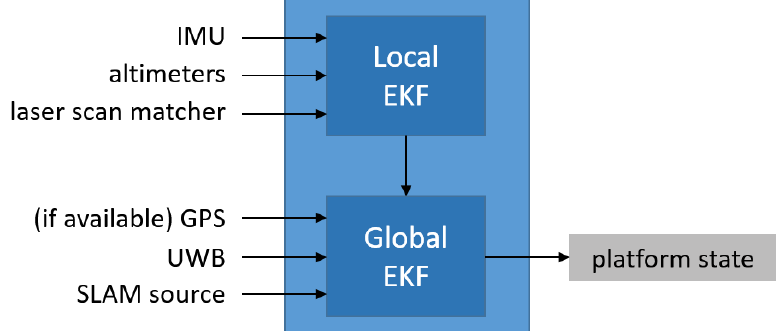
Figure 6. Full state estimator